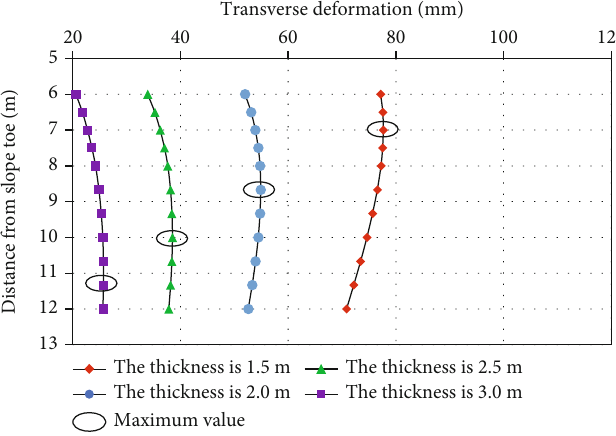
Figure 8: Transverse deformations at the ground surface with di ff erent distances from slope toe.